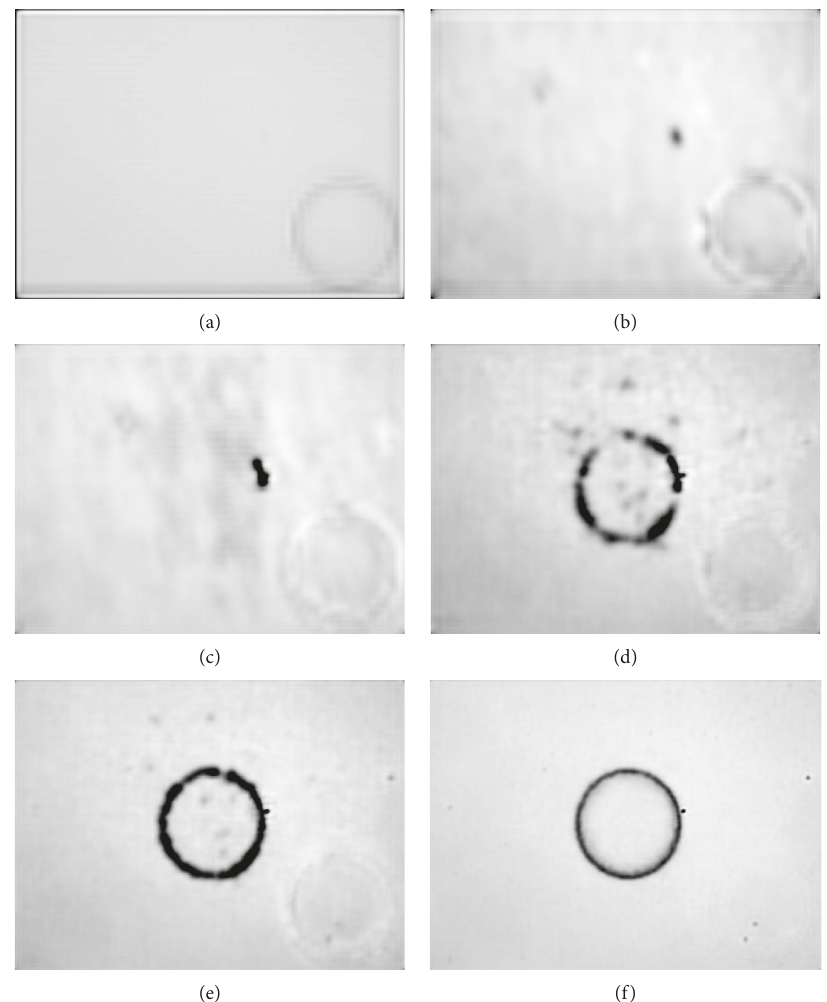
Figure 10: Change of outer PS according to training epoch. (a) 1 epoch. (b) 20 epochs. (c) 40 epochs. (d) 60 epochs. (e) 80 epochs. (f) 100 epochs.